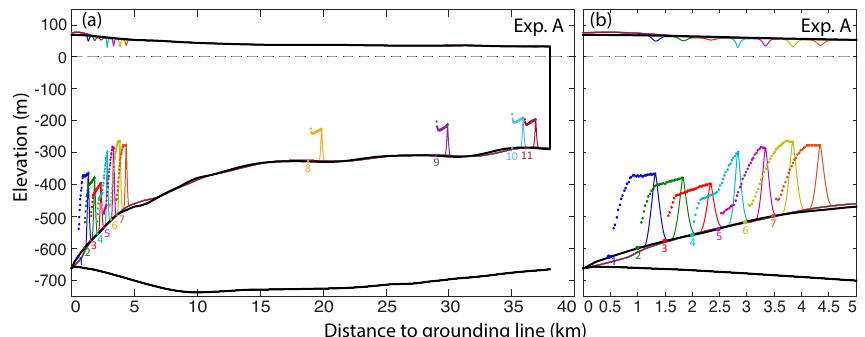
Figure 9. Crevasse propagation with the initial geometry of flow line AB. (a) Crevasse propagation of Exp. A1–A11 with FS. Each color corresponds to one initial crevasse position, indicated by the number. The solid lines are the shape of final crevasses. The dotted lines are the evolution of the tips of bottom crevasses. (b) Details of the grounding line region for Exp. A1–A7. The black lines are the initial geometry for ice surface, ice bottom and